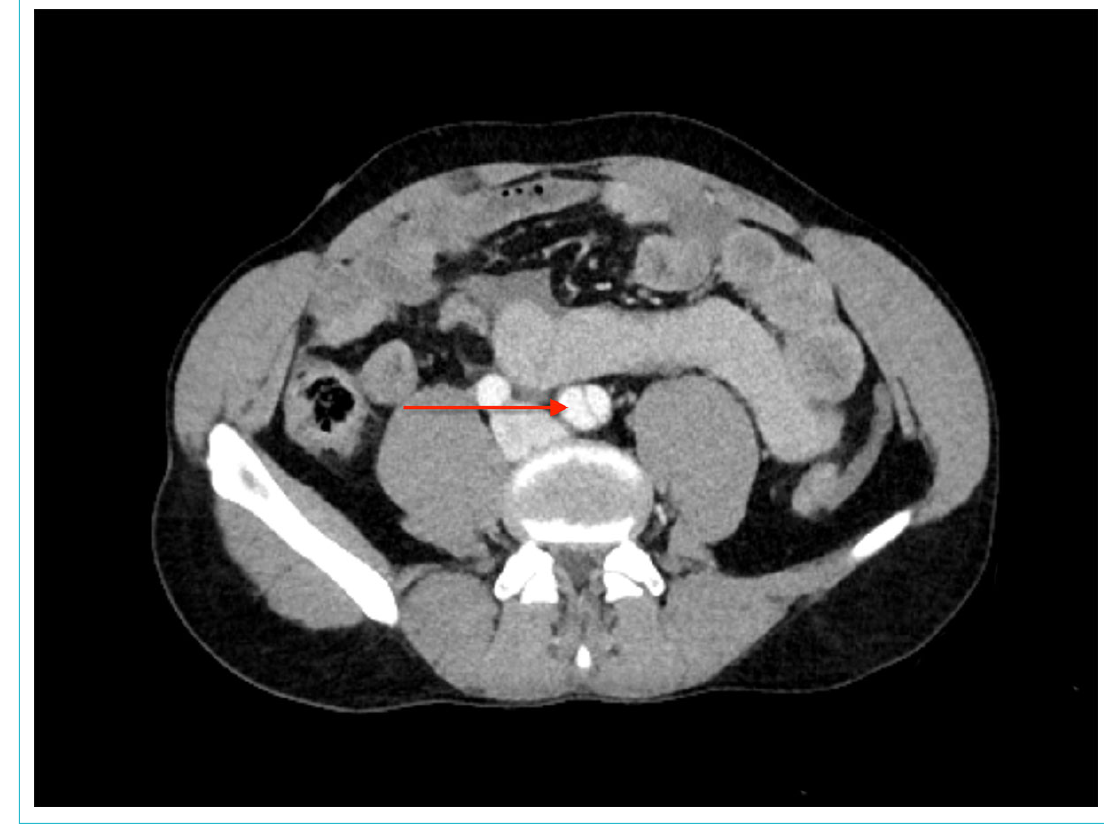
Figure 3: Emergency abdominal CT scan displaying dissection of the left common iliac artery